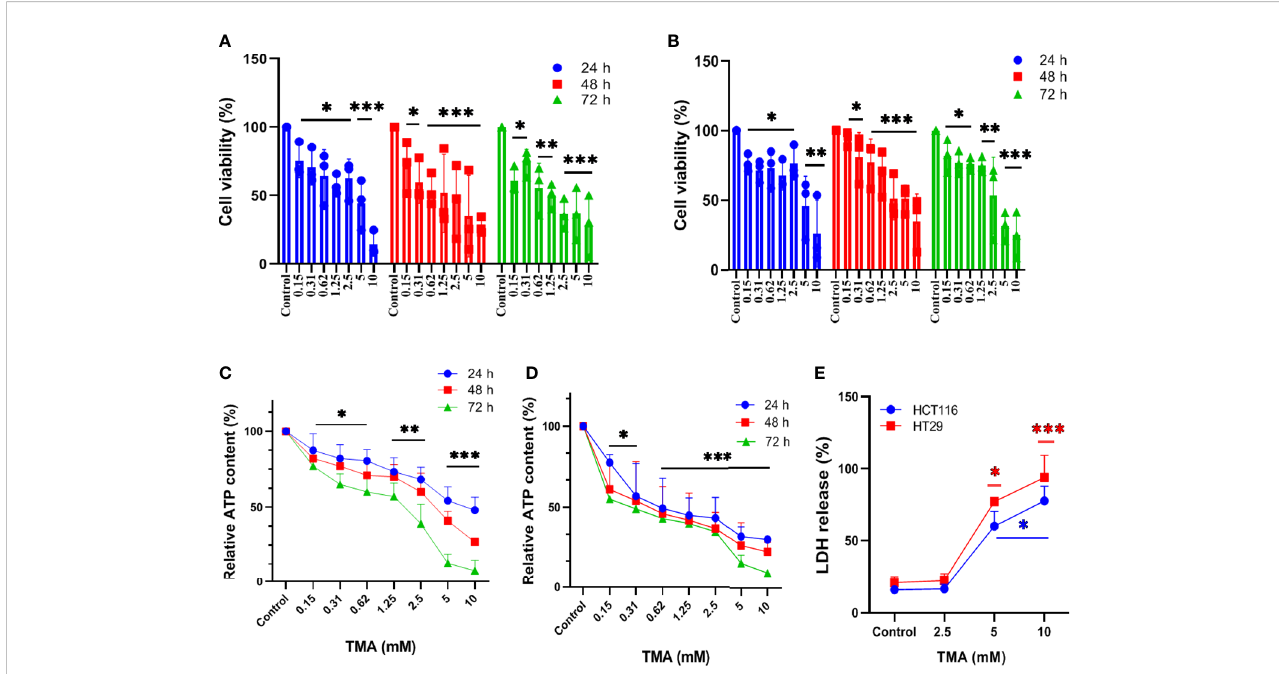
FIGURE 1 Assessment ofcellviability of HCT116 and HT29exposed with different concentrationof TMA. Cytotoxicity of TMAwas evaluated by MTT assay ( A . HCT116, (B) HT29), luminescent assay ( C . HCT116, D ) HT29) and LDH assay (E) . Cells weretreatedwith or without different concentrations of TMAfor 24h, 48 h and 72 h. Cellular viability (A, B) and membrane integrity (E) wereanalyzed colorimetrically following treatment withTMA. Below 5 mMTMA exposure, thereis no signi fi cant increase in LDHrelease compared to controlgroup. Luminescencewas measured for measuring ATP level (C, D) . Untreatedcontrol is considered as 100%. Differenceof averagevalues between untreated and treated cells weretested using one way ANOVA.All testedsubjects showedsigni fi cant decrease in viability at higher concentration ofTMA while10mMTMA at 72 h provedmost cytotoxic to cells. Signi fi cance was calculated in comparision to control. The results (mean±SEM) wereobtained from 3 independent experiments. Error bars represent standarderror fromthree independent experiments. *indicates signi fi cantlydifferent values compared tocontrol group ( P <0.05)** indicates signi fi cantlydifferent values compared tocontrol group ( P <0.001). ***indicates signi fi cantlydifferent values compared tocontrol group ( P